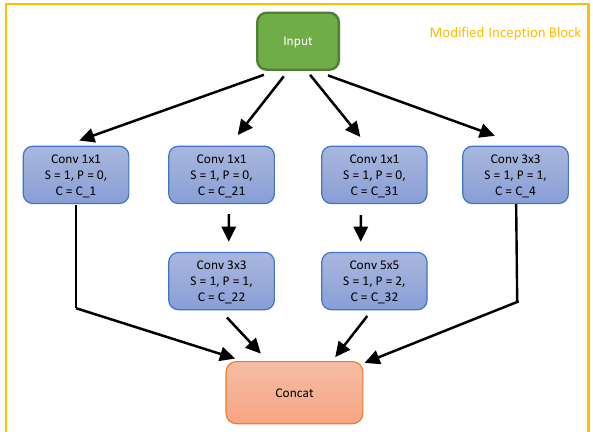
Figure 2. The proposed modified inception block. Each convolutional layer is followed by batch normalisation and a ReLU activation